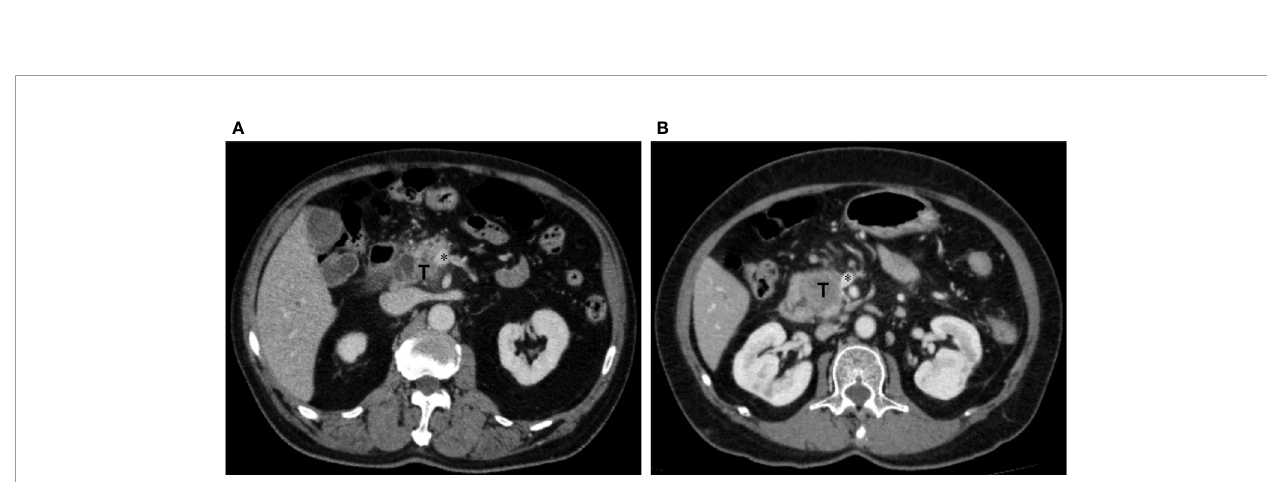
FIGURE 5 | Representative cases which were reclassi fi ed after Radscore assistance. (A) Axial portal venous phase CT image in a 73-year-old man with PDAC in the pancreatic head. The vein was suspiciously deformed (*). The Radscore prediction gave a high probability of PV-SMV invasion. The interpretation of deformity of the vein between unassisted and Radscore-assisted was discrepant for both radiologists, they assigned PV-SMV invasion category with Radscore assistance. Intraoperative exploration con fi rmed the diagnosis of PV-SMV invasion. (B) Axial portal venous phase CT image in a 66-year-old female with PDAC in the pancreatic head. The vein was interpreted as teardrop shape by the junior radiologist (*) in fi rst the reading. The Radscore prediction gave a low probability of PV-SMV invasion. The vein was interpreted as absence of teardrop shape by the junior radiologist (*) in the second reading with Radscore assistance, and PV-SMV non-invasion category was assigned. Intraoperative exploration con fi rmed the diagnosis of PV-SMV non-invasion.